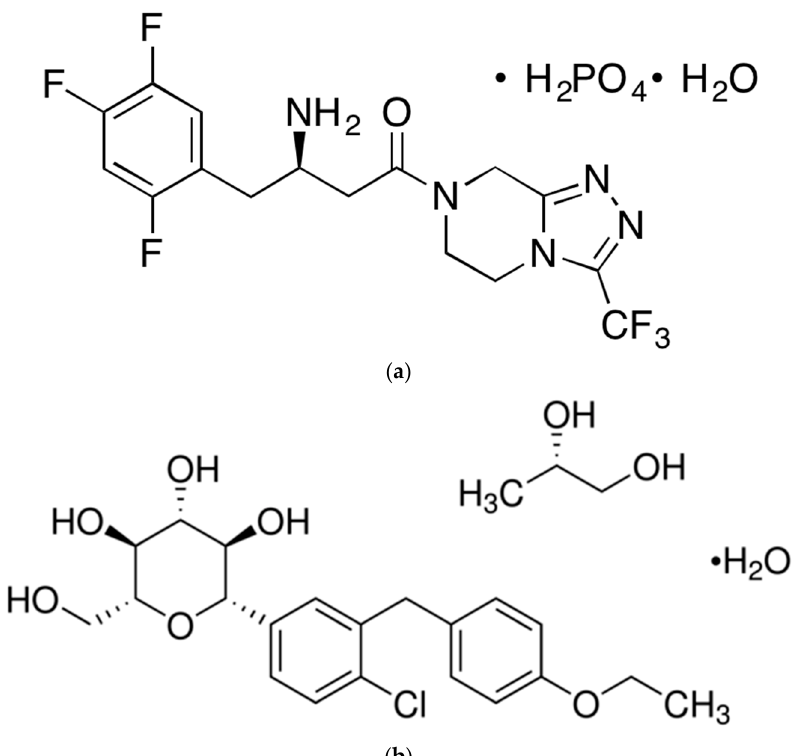
Figure 1. Chemical structure of sitagliptin phosphate monohydrate ( a ) and dapagliflozin propanediol hydrate ( b ).